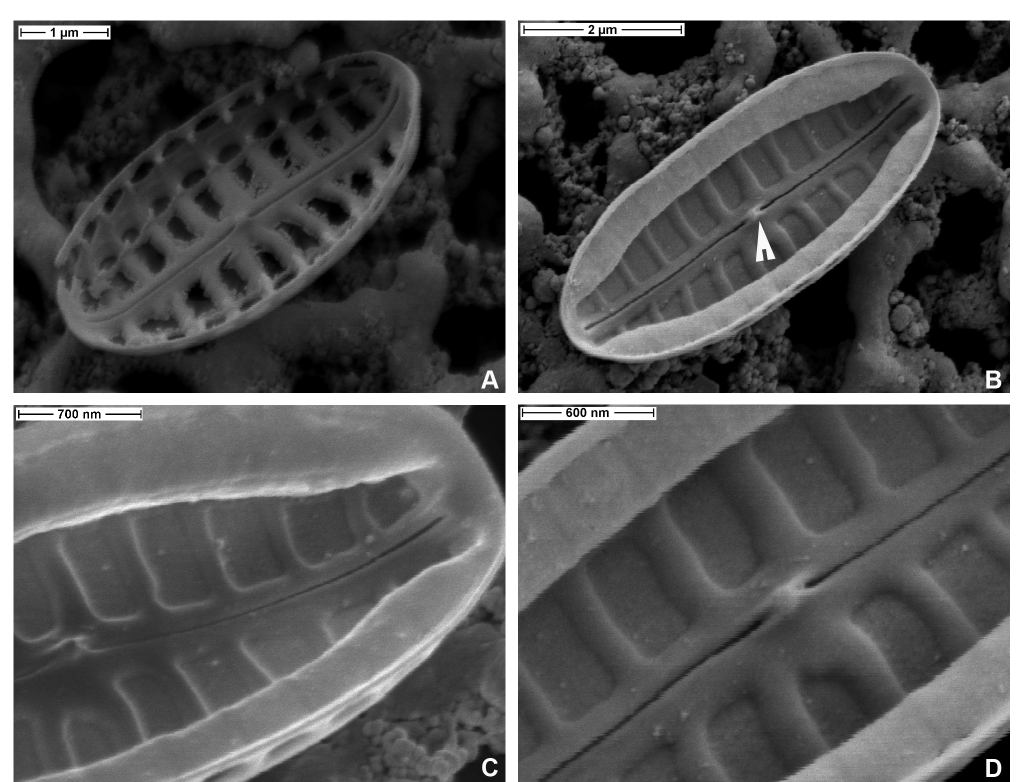
Figure 6. Biremis panamae sp. nov., SEM: internal valve views. A. Specimen with corroded chambers. B. An uneroded specimen with well preserved chambers; note the presence of a double helictoglossa (arrowhead) between the central raphe endings. C, D. Close up of the specimen illustrated in Fig. 6B: note the narrow elevated virgae, separated by depressed